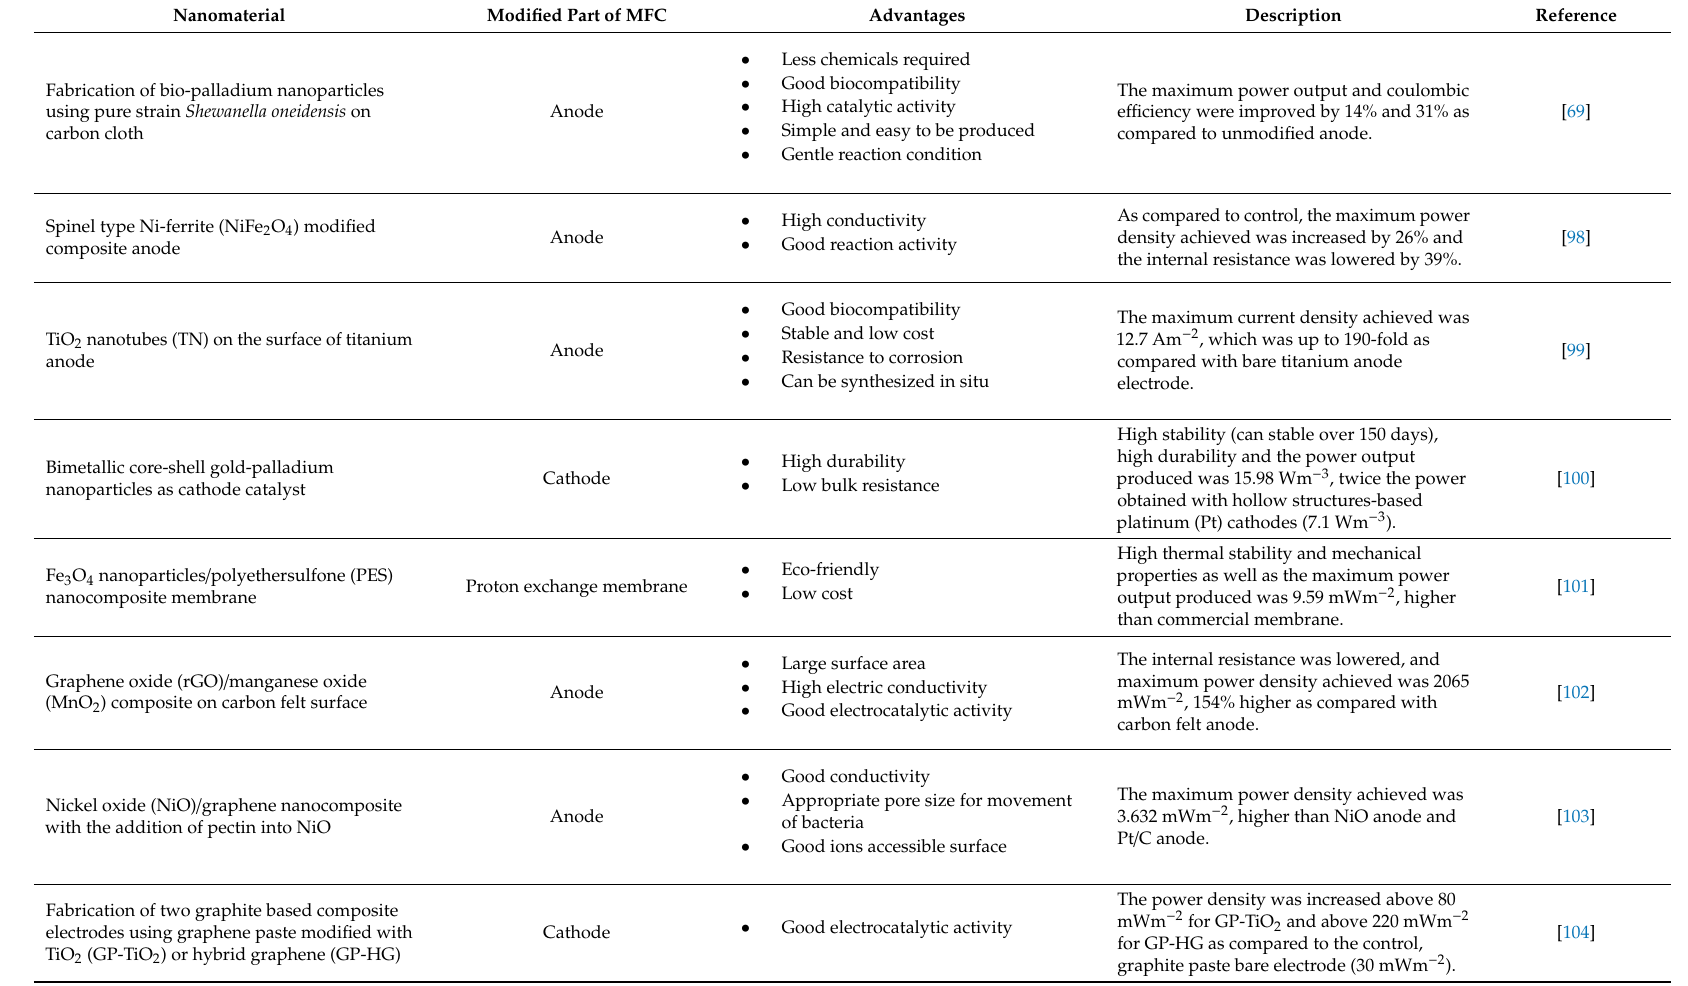
Table 3. The use of nanomaterials in the modification of components of